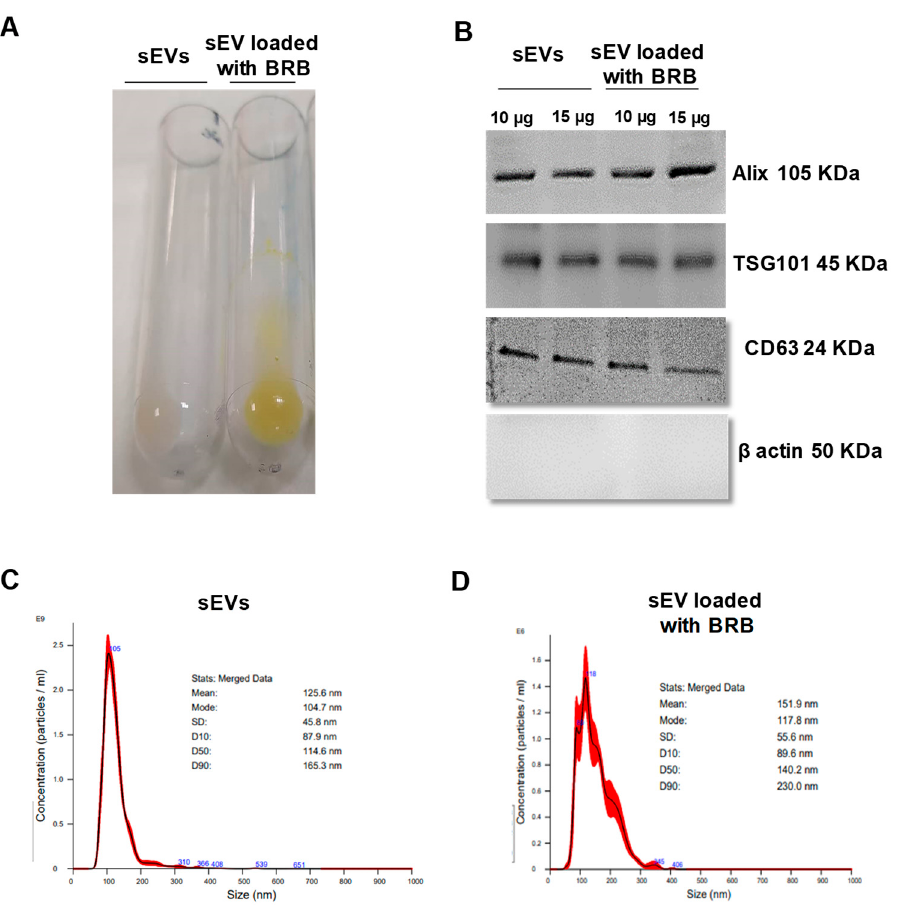
Figure 1. ( A ) Incorporation of berberine (BRB 2 mg/mL) into small extracellular vesicles (sEVs 250 µg/mL). Representative picture of sEVs loaded with BRB and native sEVs; sEVs loaded with BRB are distinguished as a yellowish band in the pellet. ( B ) Western blot analysis of Alix, TSG101, CD63, and β actin expression in sEVs and sEVs loaded with BRB. Size distributions of native sEVs ( C ) and sEV loaded with BRB ( D ) based on NTA measurements. Table 1. Entrapment efficiency, drug loading, mean particle size, polydispersity index (PDI), and zeta potential values of native sEVs and sEVs loaded with berberine